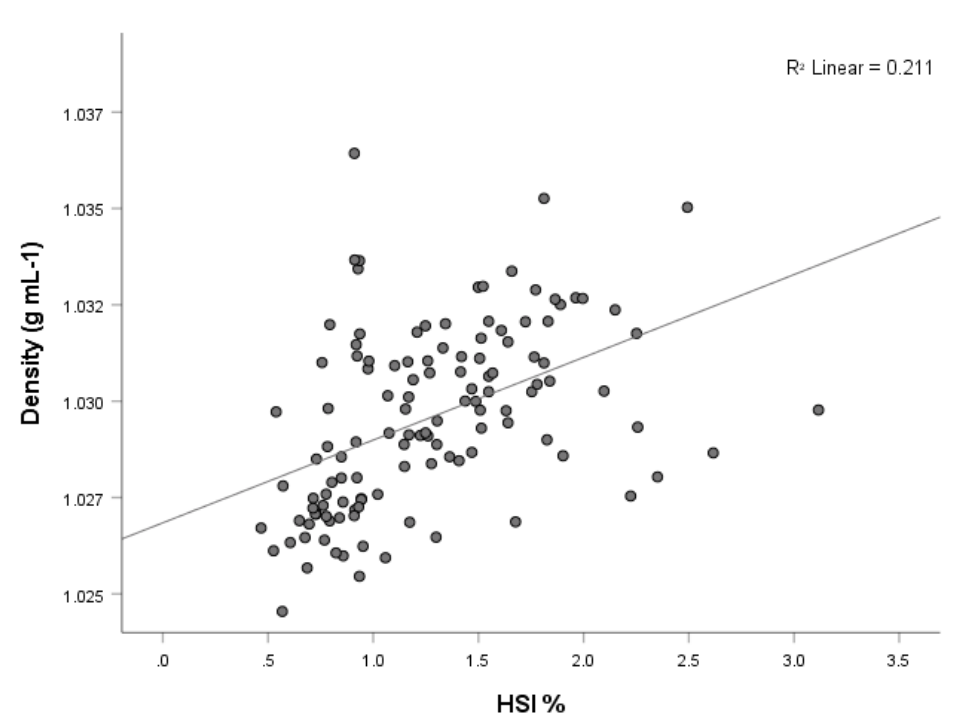
Figure 6. A scatterplot with a fit line between lumpfish body density by HSI ( n = 123). Location D is excluded from this figure. Location D was excluded from the analysis (see text for explanation).